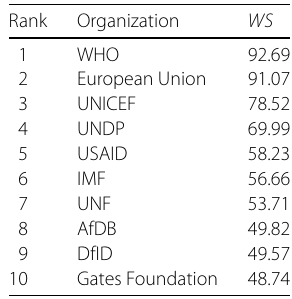
Table 2 The ten most central organizations in the citation network, and their incoming citation score Rank Organization Betweenness In- WS